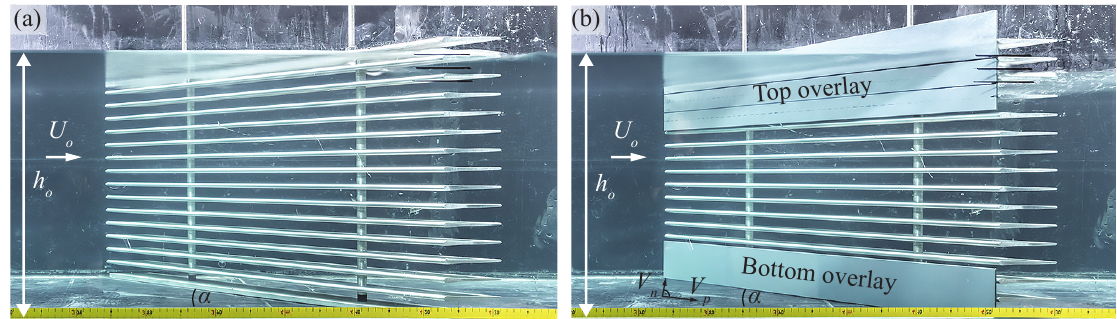
Figure 2. Definition sketch of the governing rack parameters [13].